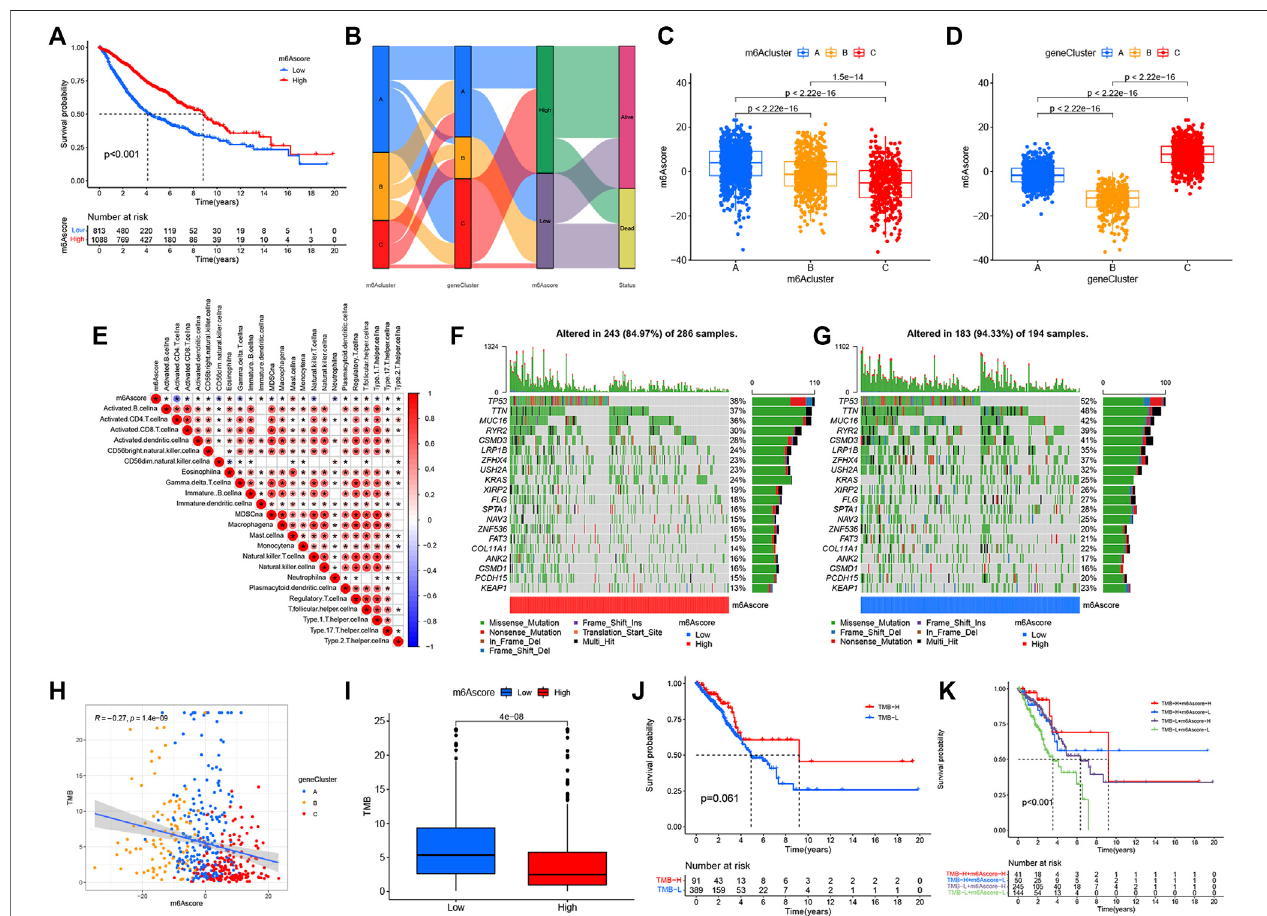
FIGURE 5 | Construction of the m6Ascore signature and tumor somatic mutation. (A) Survival analysis of patients with low m6Ascore (813 cases) and high m6Ascore (1088 cases) by Kaplan – Meier curve ( p < 0.001, log-rank test). (B) Alluvial map showing changes in m6Aclusters, geneCluster, m6Ascore, and status. (C) Comparisonofm6Ascoreacrossthethreem6Amodi fi cation patterns. (D) Comparisonofm6AscoreacrossthreegeneClusters. (E) Spearman ’ sanalysisofcorrelations betweenm6AscoreandTMEin fi ltratingcells.Bluerepresentedanegativeassociationand redrepresentedapositiveassociation. (F,G) Waterfalldiagramoftumor somaticmutationestablishedbyhighm6Ascore (F) andlowm6Ascore (G) .Eachcolumnindicatedanindividualpatient.The fi gureaboveshowedTMB,andthenumber on the right represented the mutation frequency of each gene. The bar graph on the right showed the proportion of each variation type. (H) Correlations between TMB, m6Ascore,and geneClusterusing Spearman ’ sanalysis. (I) Comparison ofTMBbetweenhigh- andlow-m6Ascore groups. (J) Kaplan – Meiercurves forsurvivalanalysis of patients with low (389) and high (91) TMB in TCGA – LUAD cohort ( p = 0.061, log-rank test). (K) Kaplan – Meier curve analysis of survival in “ TMB-H + m6Ascore-H ”